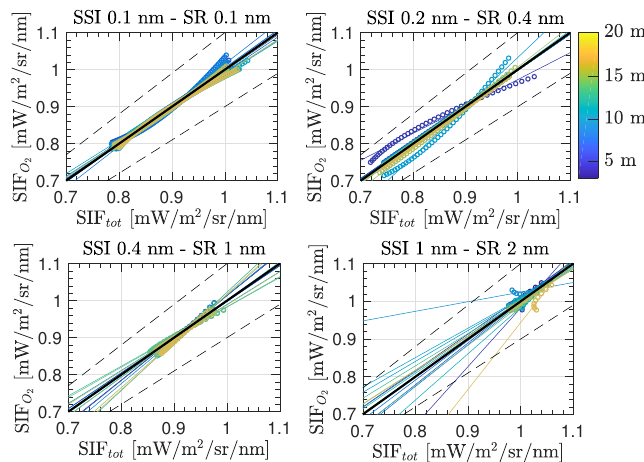
Figure 13. Scatter plots of estimated SIF using the proposed SFM retrieval approach to compensate (1) for oxygen effects and (2) for total atmospheric transmittance, accounting in both cases for the instrument spectral convolution effects at different instrument resolutions and sensor heights between 3 m to 20 m (colour scale). Coloured solid lines are regression lines for the range of sensor heights evaluated while actual estimations are marked as circles. The black solid lines represent the 1:1 line and dashed lines define the areas having a SIF relative error lower than